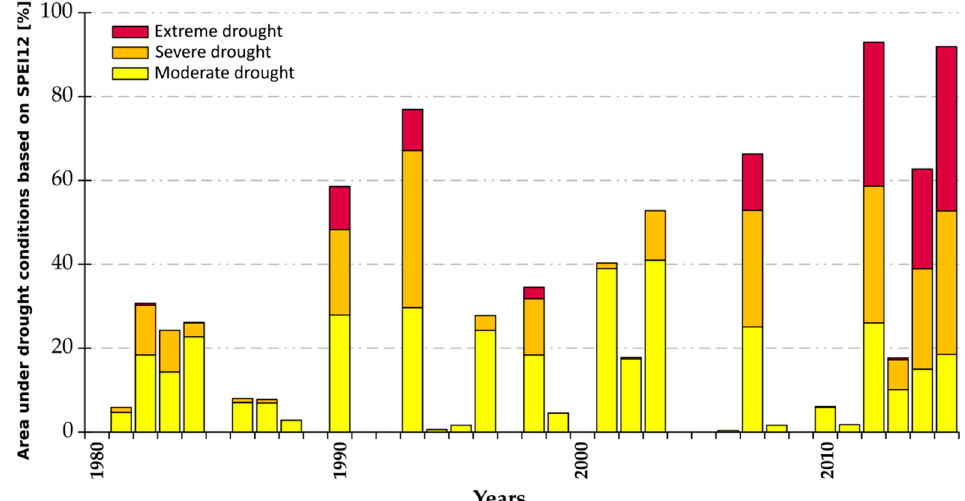
Figure 5. Percentage of area under drought conditions according to the values of SPEI12 at December in the SFRB during 1980–2015. The calculation of the area under drought conditions is based on the number of pixels within the SPEI drought categories: moderate dry, severe dry, and extreme dry shown in Table 2. The reference period of 1980–2015 was chosen for the calculation of the SPEI. In order to have a more complete picture of the area under drought conditions in the SFRB, the SPEI3 drought categories for each season were analyzed (Figure 6). All SPEI3 drought categories showed a positive Theil–Sen’s slope, which indicates the increasing of the area under drought conditions. However, only those classified as moderate drought or extreme drought exhibited a significant monotonic trend (Theil–Sen’s slope: 0.379% and 0.01% with α = 0.05 for moderate and extreme droughts) into the winter season (i.e., JJA) since the 1980s.